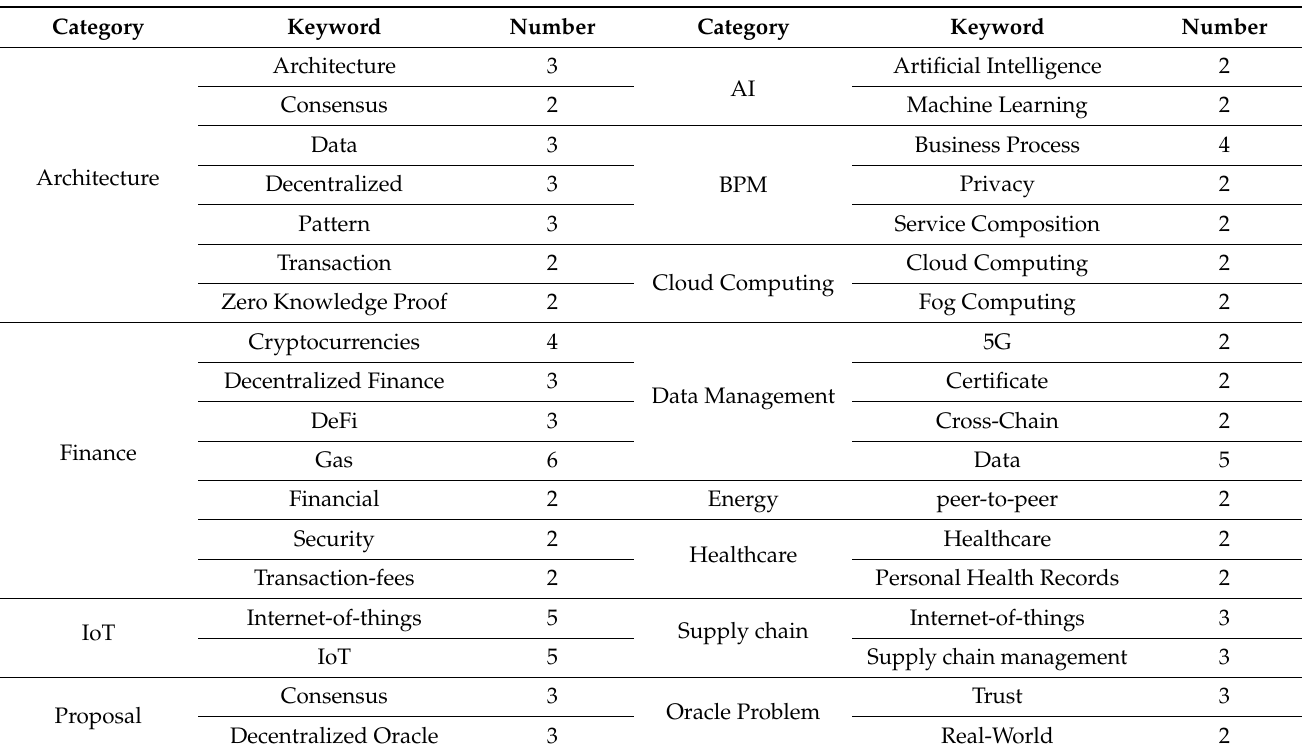
Figure 6. Keywords word cloud. Table 8. Keywords by category.